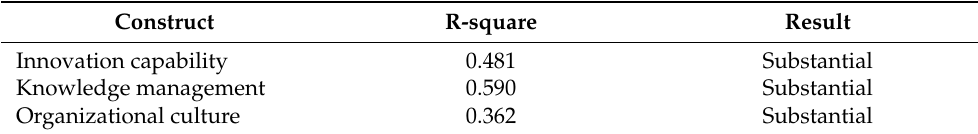
Table 6. R-square of endogenous